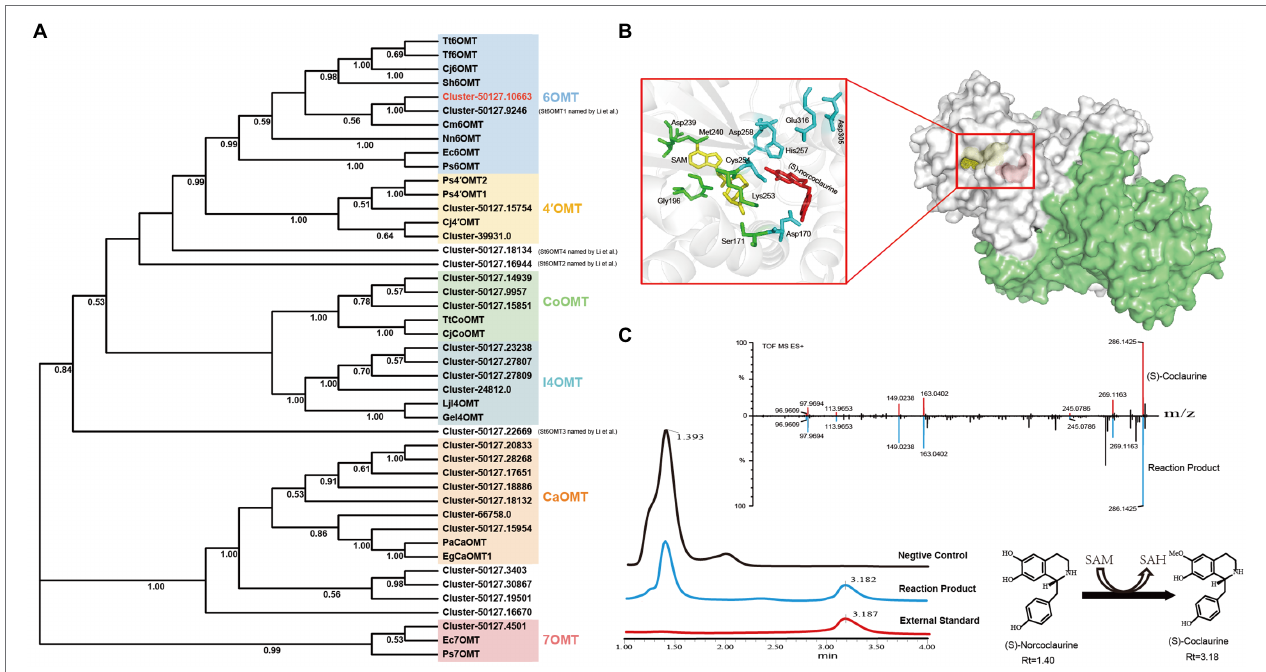
FIGURE 5 | Phylogenetic relationships of OMTs and catalytic activity analysis recombinant St6OMT2. (A) Phylogenetic tree of OMTs. 6OMT: (S)-norcoclaurine-6-O- methyltransferase, 4 ′ OMT: 3 ′ -hydroxy-N-methyl-(S)-coclaurine 4-O-methyltransferase, CoOMT: columbamine O-methyltransferase, CaOMT: caffeic acid O-methyltransferase, I4OMT: isoflavone 4-O-methyltransferase, 7OMT: reticuline 7-O-methyltransferase. (B) Structural analysis of recombinant St6OMT2. Overall view of the St6OMT2 dimer structure and shown in surface representation. The ligand (S)-norcoclaurine and SAM were displayed in dots and colored yellow and red, respectively. In the close-up view, the substrate pocket is shown in cartoon representation, and the residues binding to SAM and (S)-norcoclaurine were displayed in stick and colored green and cyan. The ligand (S)-norcoclaurine and SAM were displayed in stick and colored red and yellow, respectively. (C) Enzymatic activity of recombinant St6OMT2 on (S)-norcoclaurine assayed by